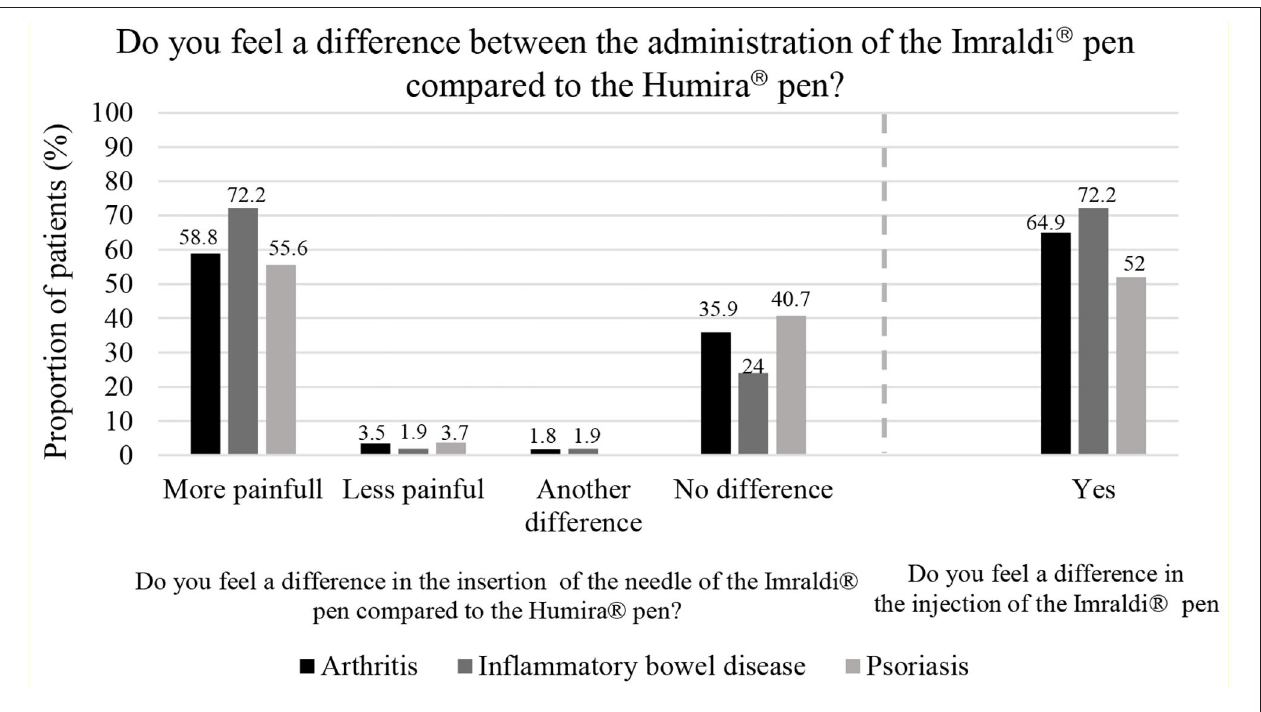
FIGURE 3 | Participants’ comparison of the administration of Humira ® and Imraldi ®